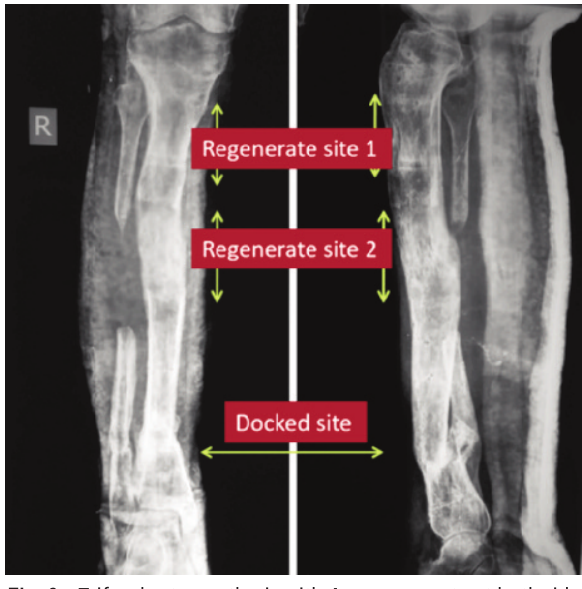
Trifocal osteosynthesis with 4cm regenerate at both side Fig. 6: of docking.